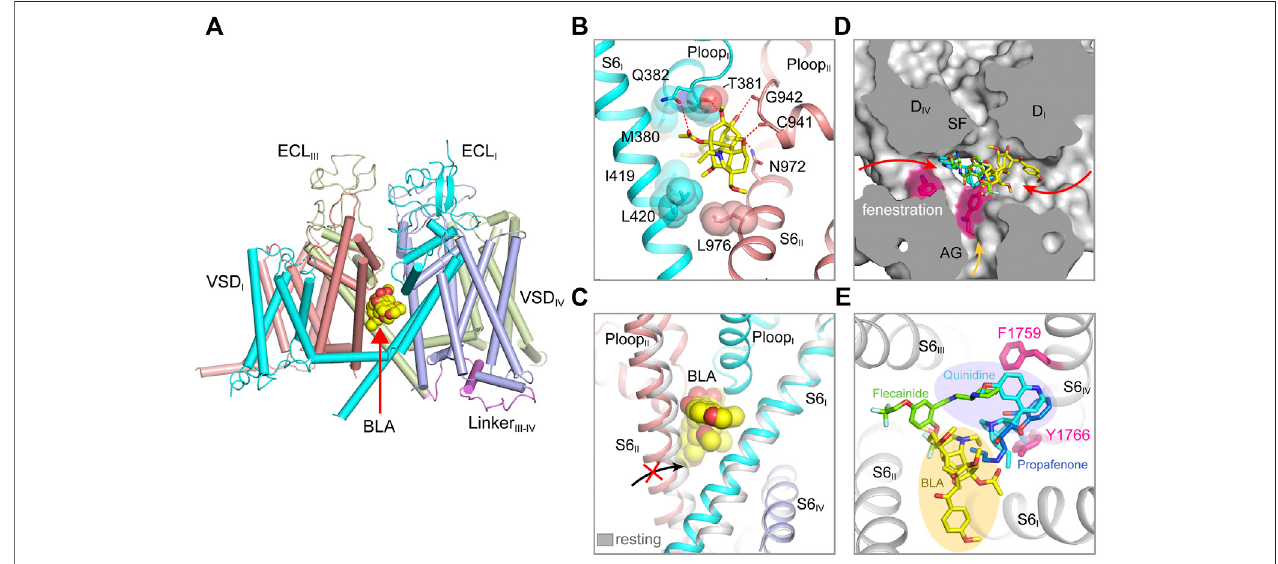
FIGURE 3 | Pore modulators of mammalian Na V channels. (A) The binding site of site-2 neurotoxin BLA in Na V 1.3 (PDB code: 7W77). BLA is depicted in spheres. (B) Aclose-upviewoftheBLAbindingsite.Keyinteractingresiduesareshownsidechainsinsticks.BLAisshowninsticks. (C) BLAbindingpreventsS6 II helixshiftingto the resting state. (D) Superposition of Na V structure bound BLA (PDB code: 7W77), Flecainide (PDB code: 6UZ0), Propafenone (PDB code: 7FBS) and Quinidine (PDB code: 6LQA) in the pore. Arrows indicate possible access path for the drugs. (E) Top-down view of the BLA binding site and the antiarrhythmic drug binding sites from panel (D)